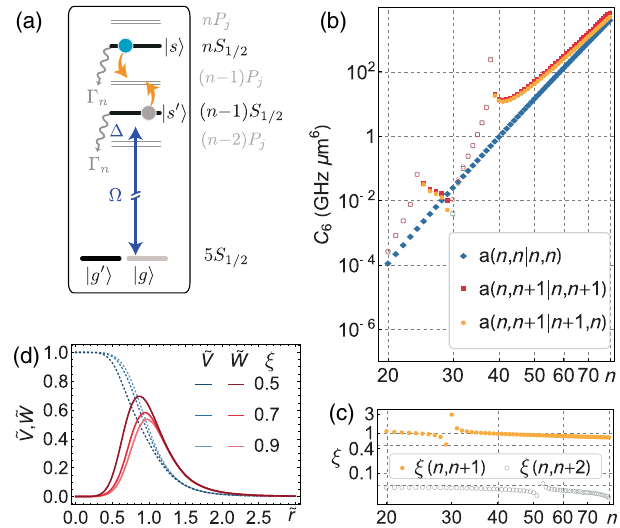
FIG. 6. (a) Atomic level scheme (see text). (b) vdW coefficients between Rydberg nS 1 and n 0 S 1 states as a function of = 2 = 2 principal quantum number n . Negative values are plotted as outlined markers, positive values as filled. (c) Ex- change interaction strength ξ ð n; n þ δ n Þ ≡ a ð n þ δ n j n; n þ δ n Þ = a ð n; n þ δ n j n; n þ δ n Þ as a function of principal quantum num- ber n . (d) Effective interaction potentials of Eq. (15) for ξ ¼ 0 . 5 , 0.7, and 0.9, e.g., corresponding to n ¼ 29 , 90, and 27,